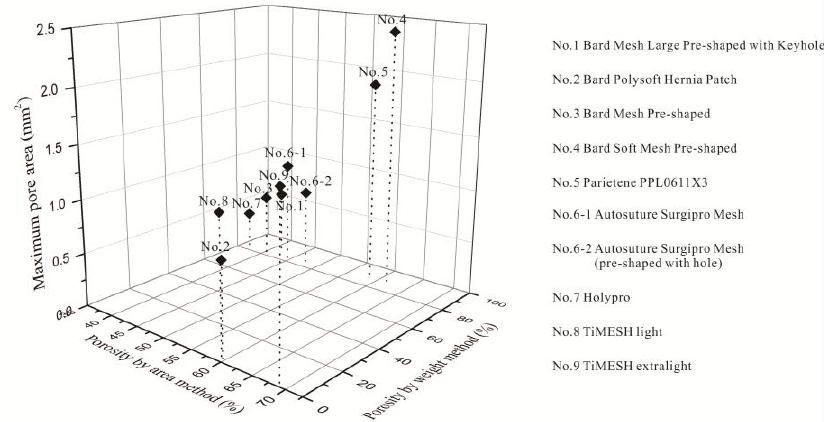
Figure 5. Maximum pore areas and porosities by the two measurement methods: area vs. weight.